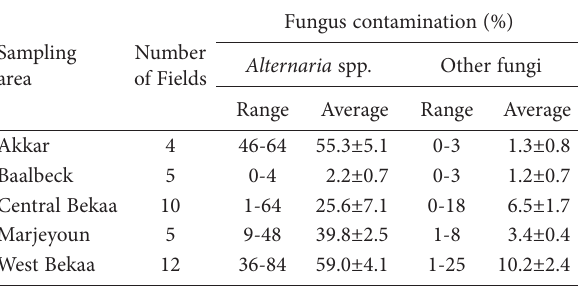
Table 1. Fungus contamination detected in durum wheat kernels collected from different sampling areas of